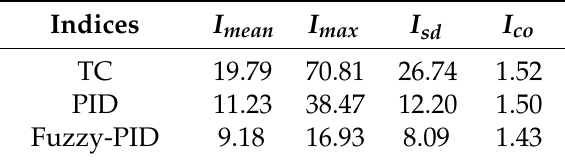
Table 4. Indices for the second set of experiments.